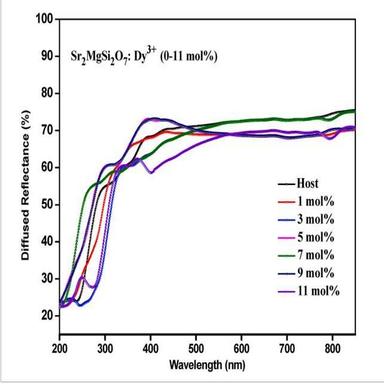
Diffuse reflectance spectra of Sr2MgSi2O7:Dy3þ NPs.